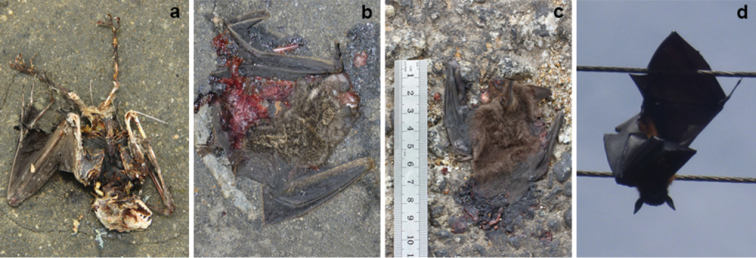
Dead specimens recorded in the peripheral areas of Maduru-Oya National Park aCynopterussphinxbPhoniscuscf.jagoriicRhinolophusrouxiidPteropusgiganteus.